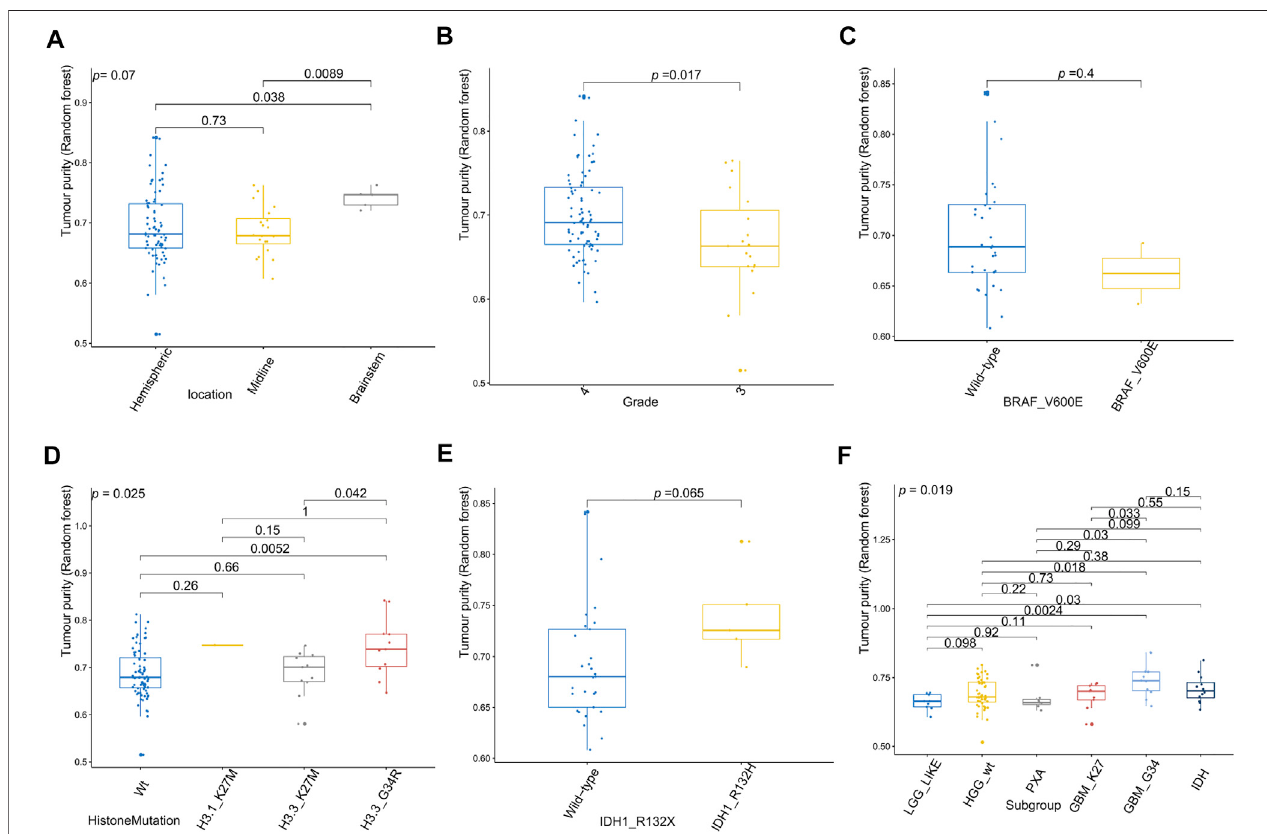
FIGURE6| Relationshipbetweentumorpurityofhigh-gradeglioma(HGG)andthepatients ’ clinicalmolecularfeaturesintheE-MTAB-5528dataset. (A) Boxplotof the tumor purity by tumor location; (B) box plot of the tumor purity by tumor grade; (C) box plot of the tumor purity by BRAF_V600E mutation status; (D) box plot of the tumor purity by histone mutation status; (E) box plot of the tumor purity by IDH1 mutation status; (F) box plot of the tumor purity by molecular subgroup.